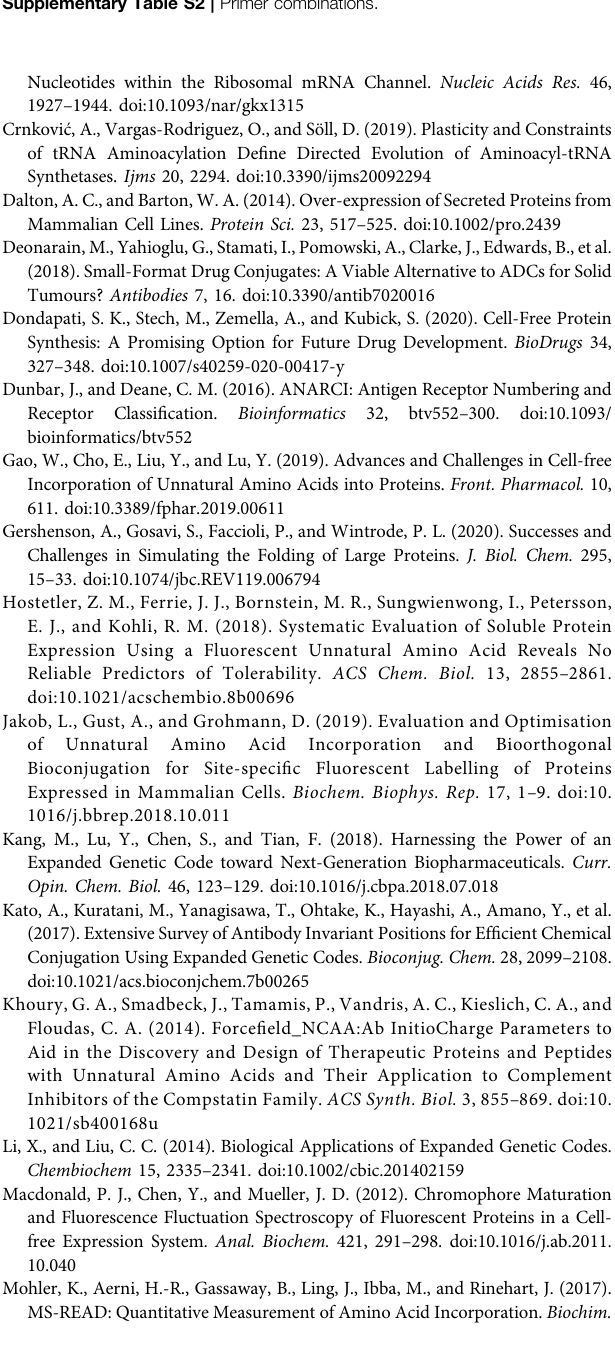
Supplementary Figure S6 | Quanti fi cation of fl uorescence for amber suppression of reporter RFP-X-GFP with varying concentrations for orthogonal components and SDS-PAGE autoradiography. Supplementary Figure S7 | Fluorescence of RFP-scFv-GFP amber mutants and reporter proteins RFP-X-GFP and RFP-Y-GFP. Supplementary Figure S8 | Plasmid sequences. Supplementary Table S1 | Primer sequences. Supplementary Table S2 | Primer